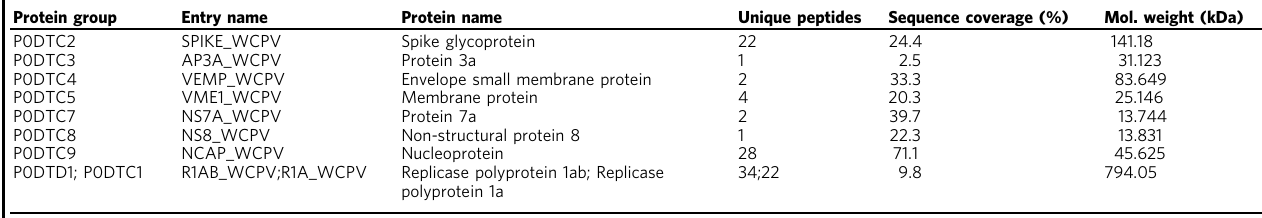
Table 1 SARS-CoV-2 proteins identi fi ed by data-dependent analysis (DDA). Protein group